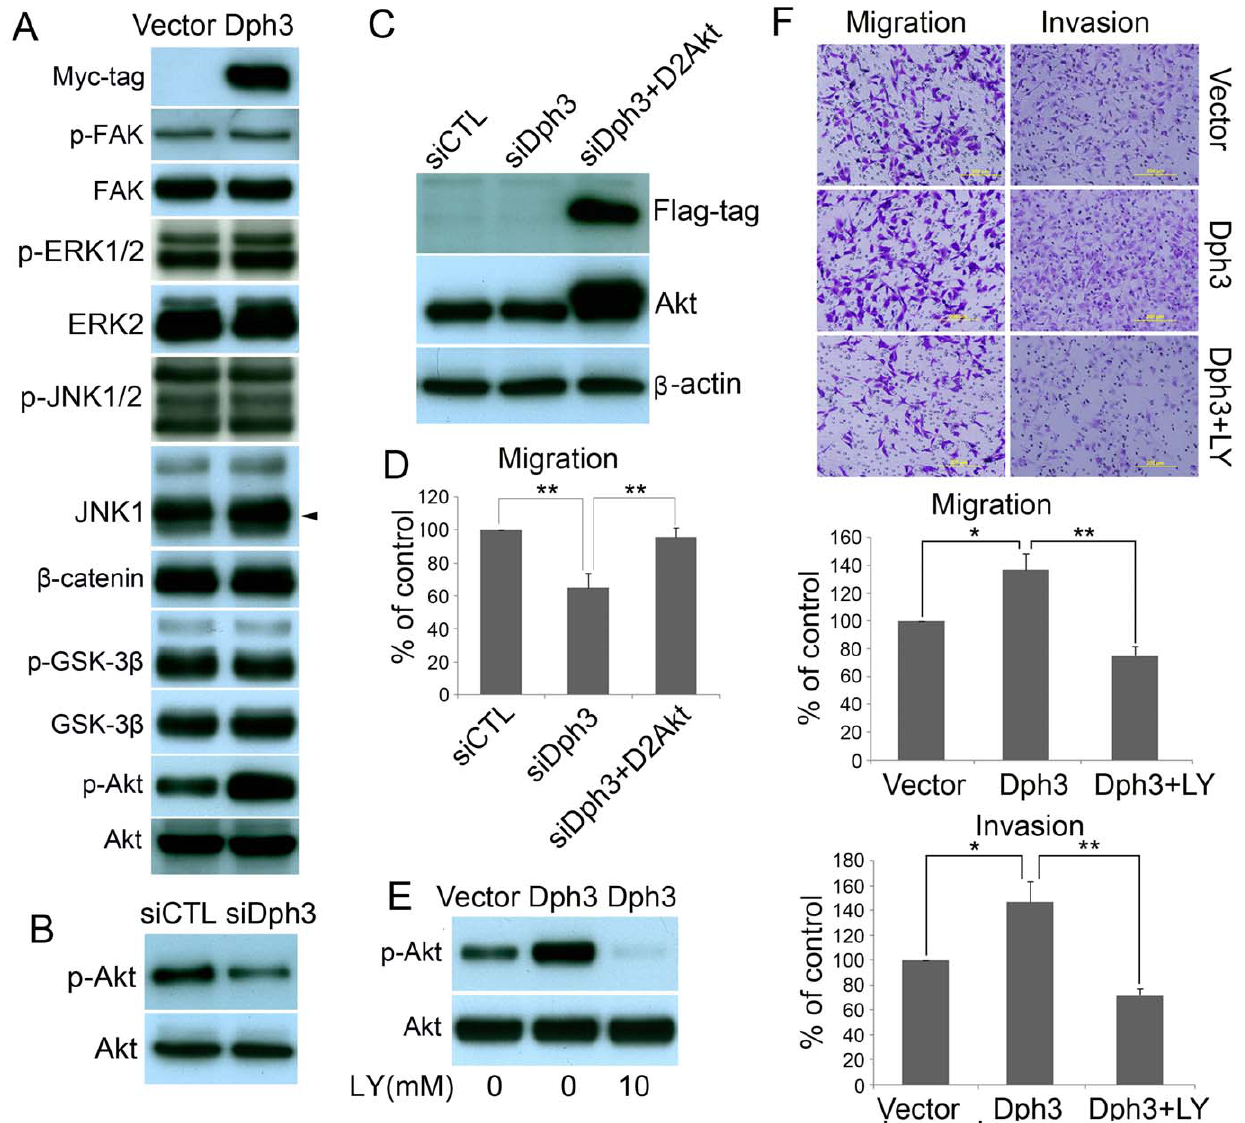
Figure 6. Dph3 facilities the invasion and migration of melanoma cells via AKT pathway. A, western blot shows that the phosphorylation of AKT at Ser-473 was elevated in cells transfected with pIRES-EGFP-Dph3. AKT was used as a loading control. B, the phosphorylation of AKT at Ser- 473 was perturbed in cells transfected with Dph3 siRNA plasmid. AKT was used as a loading control. C, expression of D2AKT was confirmed by western blot with antibody against Flag-tag and AKT, and b -actin was used as loading control. D, transwell assays were performed to determine the motility of cells cotransfected with Dph3 silencing plasmid and D2AKT plasmid. Columns are data collected from three independent experiments. E, in the presence of LY294002 (20 m M), cells were incubated for 1 h, protein extracts were analyzed by western blot with antibodies against phosphorylated AKT (S473) or AKT. F, in the presence of LY294002 (20 m M), transwell assays (left panel) and Matrigel invasion assays (right panel) were conducted to evaluate the cell motility and invasiveness after transfection. Representative pictures were taken after staining with crystal violet. Columns are data collected from three independent experiments and are average 6 S.E. values. *p , 0.05, **p , 0.01, compared to control cells.